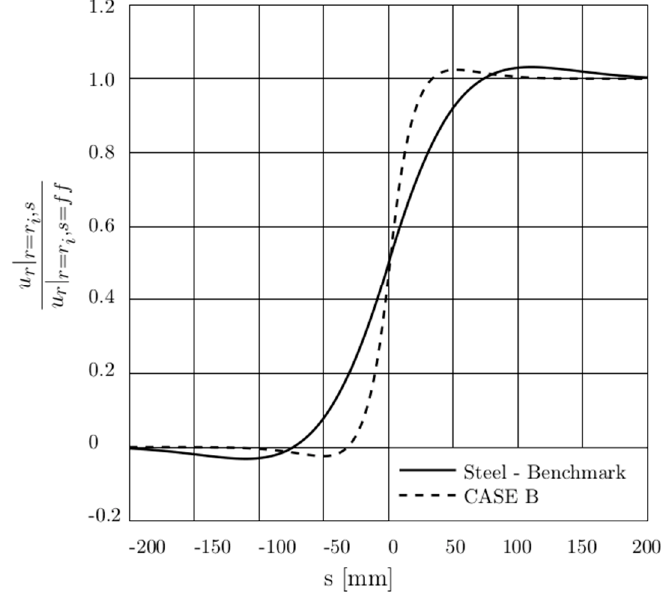
Figure 5. Relative radial deformation versus distance from the sealing point.